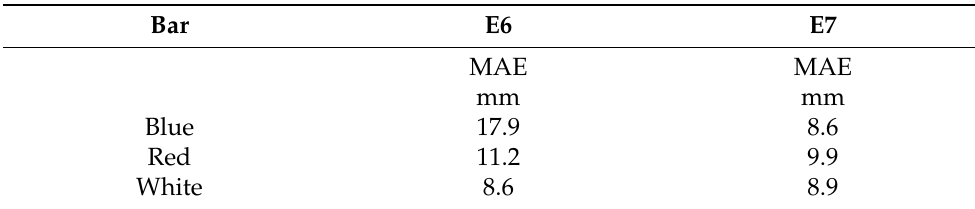
Table 9. MAE in mm between benchmark and filtered lengths estimated from the entire sequence of RGB and NIR images of the colored and white bars treated with the large crop. Bar E6 MAE Blue